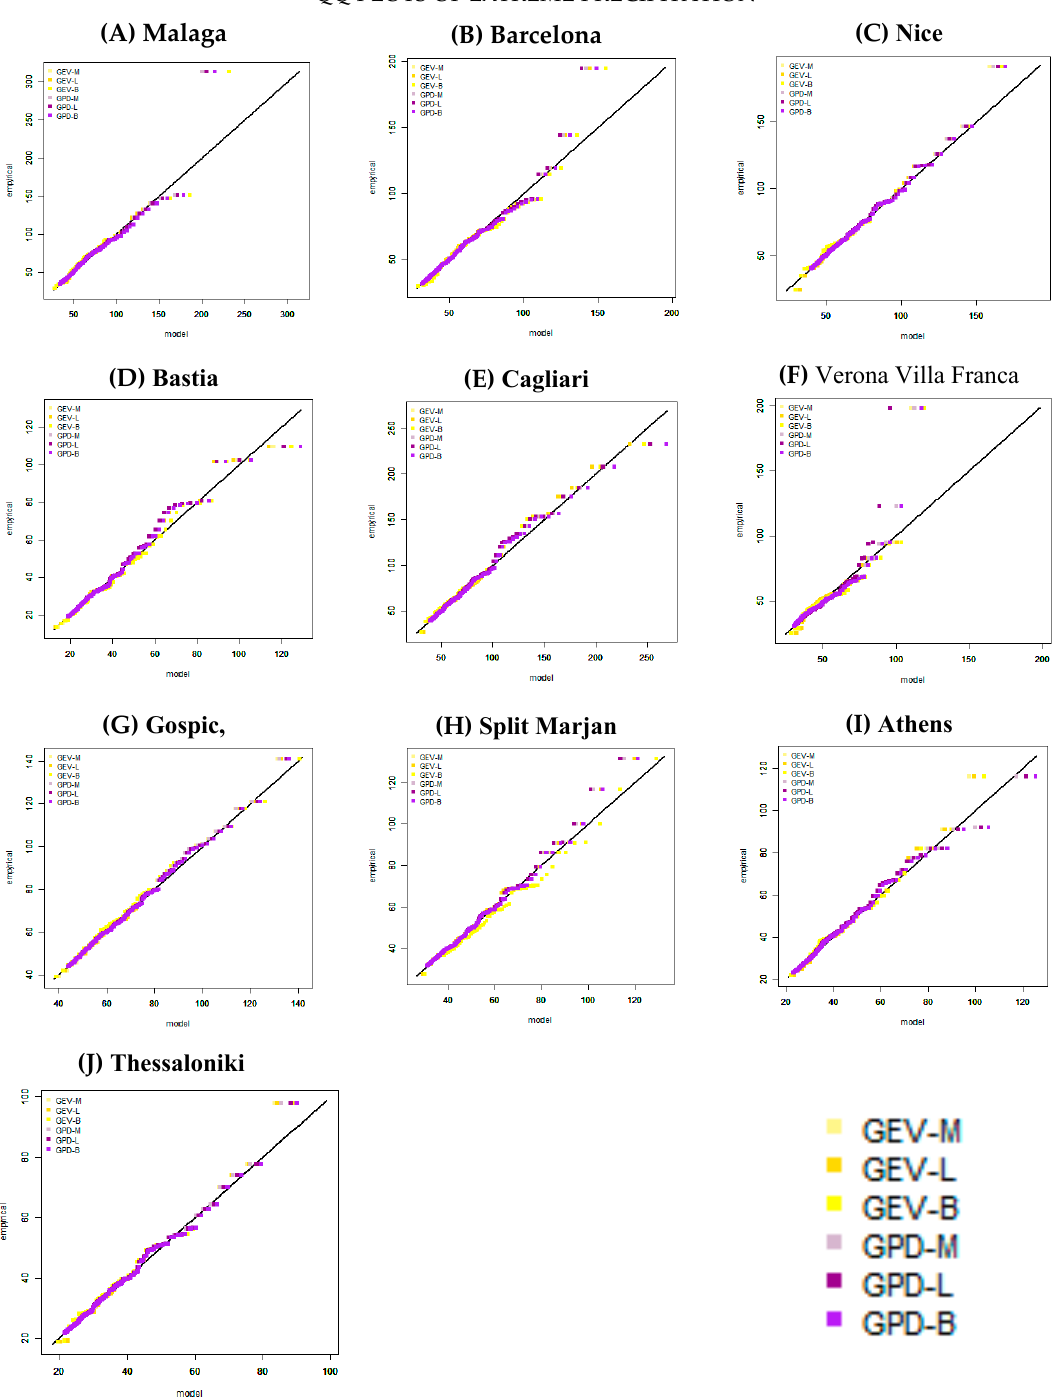
Figure 3. QQ plots for the 10 studied stations (from A to J ) using six different statistical methods (GEV-M, GEV-L, GEV-B, GPD-M, GPD-L, GPD-B). X-axis provides the models values and Y-axis the empirical